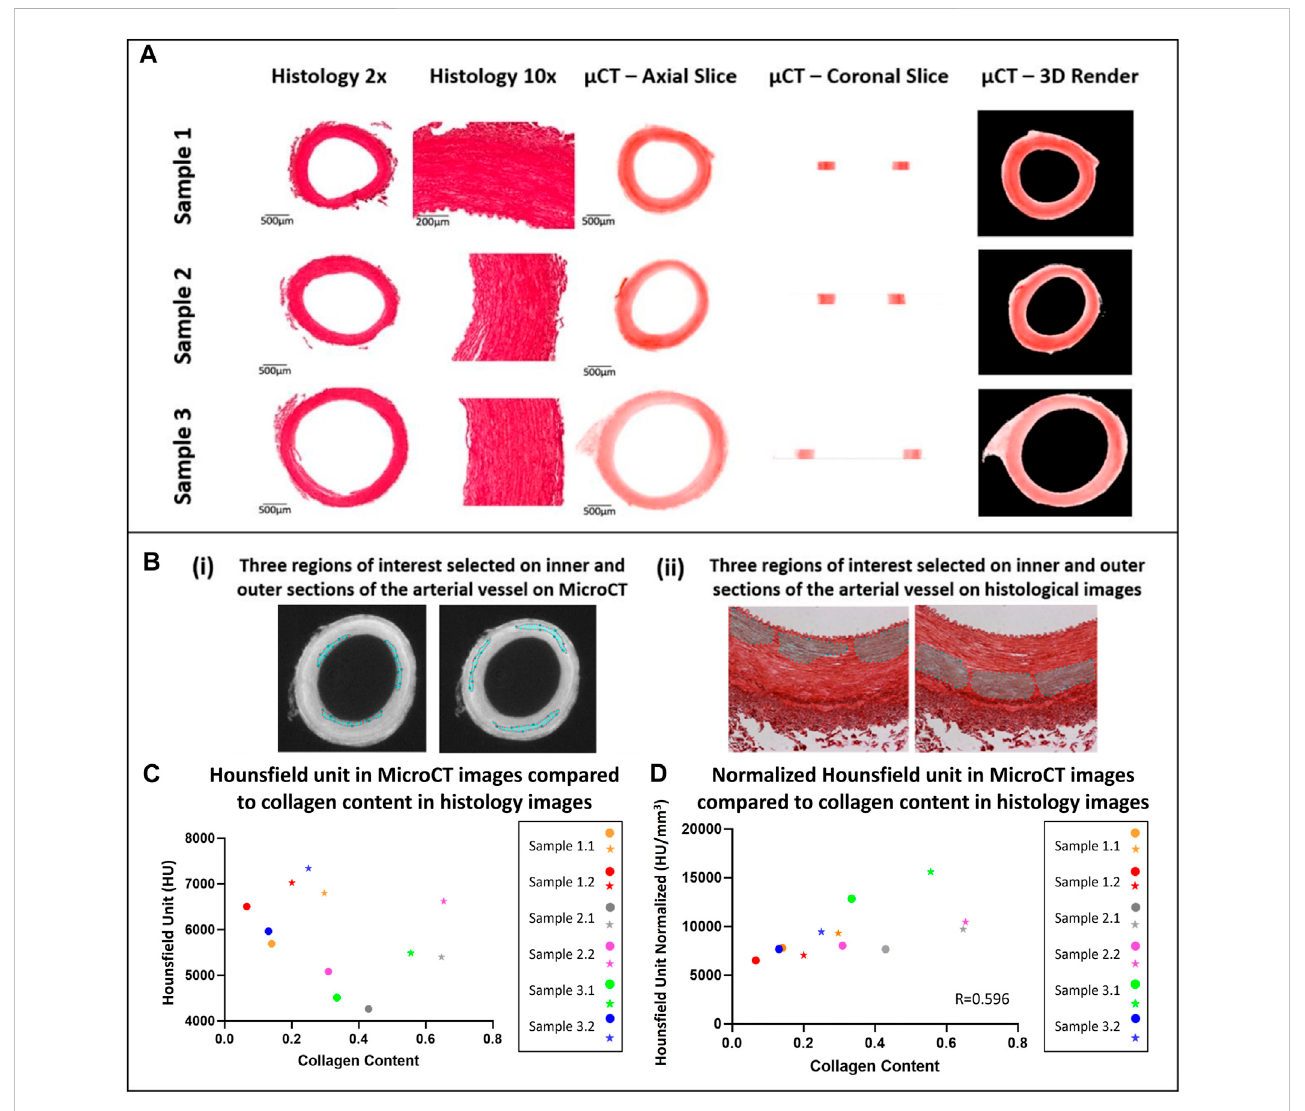
FIGURE 4 QualitativeandquantitativecomparisonofMicroCTtohistology (A) Qualitativecomparisonobservingtheoverallstructureofporcinecarotidarteries. (B) Region of interest selection for quantitative comparison of the collagen content observed in porcine carotid arteries. (C) Increase in collagen content observedindifferentsectionsofvesselwallwherebytheexternalmediapresenthighercollagencontentandHUthentheinternalmedia,internal(circles)and external (stars) regions of interest in the media. (D) Pearson correlation between HU from MicroCT and collagen content from PS-Red images when normalised with respect to